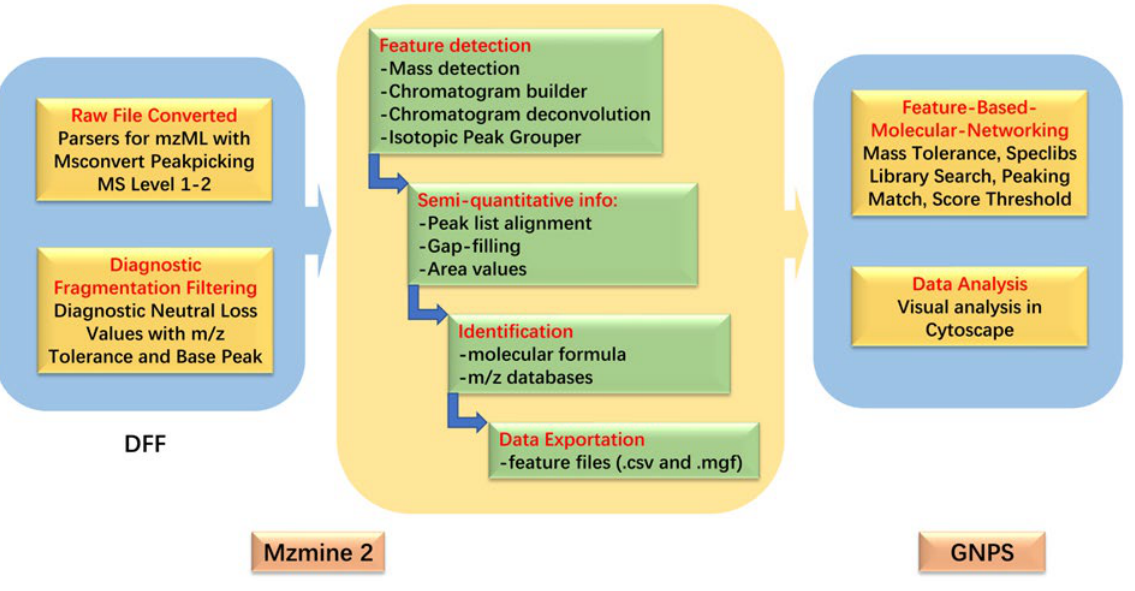
Figure 6. Data processing and